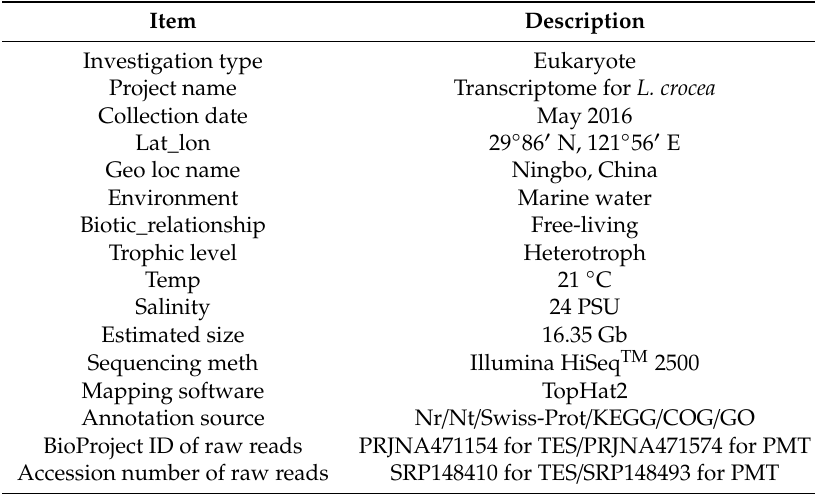
Table 1. MIxS information for the transcriptome of L. crocea .